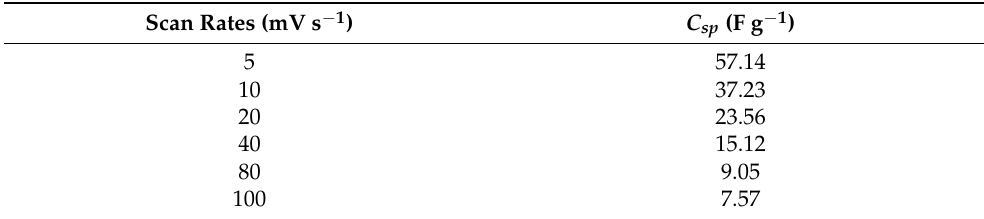
Table 6. Variation in specific capacitance at different scan rates for the fabricated